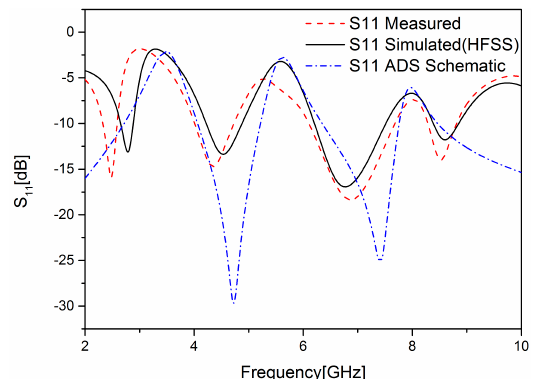
Figure 11. Input Impedance results of the proposed antenna.